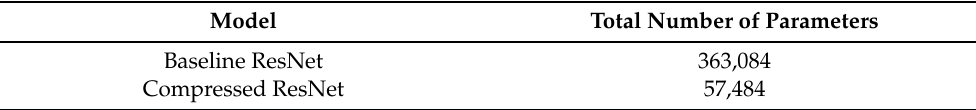
Figure 9. Compressed ResBlock1 and Compressed ResBlock2 are composed of replacing 2D convolu- tion with time-frequency separable convolution. Table 5. Summary model parameters for ResNet